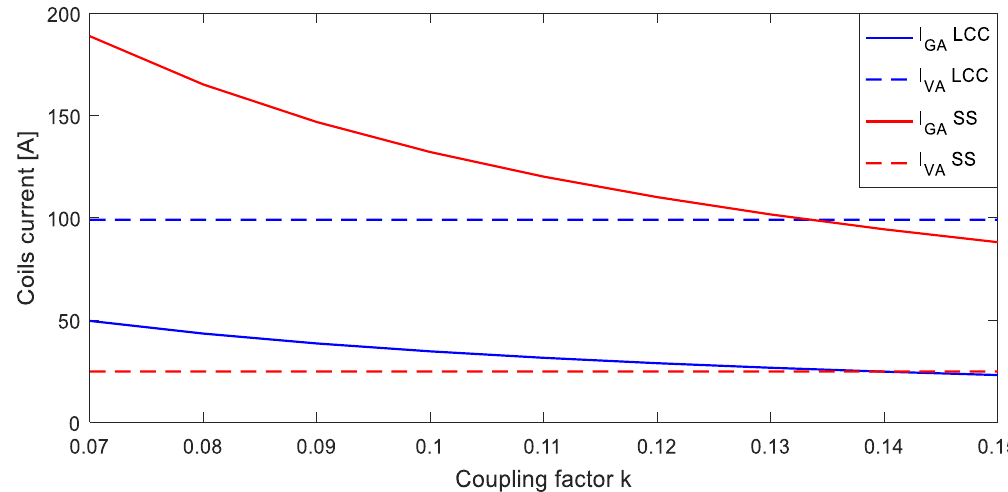
Figure 12. Coil currents (rms) distribution using SS and LCC compensations versus coupling factor k.